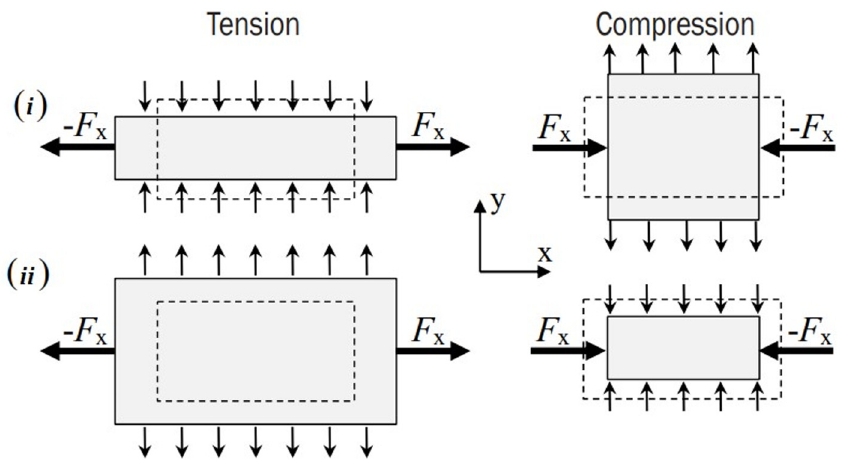
Figure 3. Mechanical behavior applying a tensile and compressive load—( i ) non-auxetic material and ( ii ) auxetic material. Reproduced from source [27] under CC-BY licence.